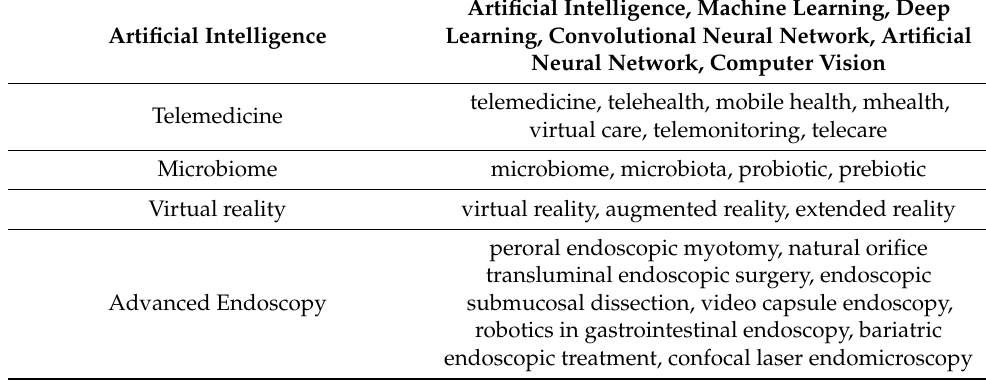
Table 1. List of terms used to classify entries into five innovation research fields: artificial intelligence (AI), virtual reality (VR), telemedicine, the microbiome, and advanced endoscopy. Artificial Intelligence, Machine Learning, Deep Artificial Intelligence Learning, Convolutional Neural Network,